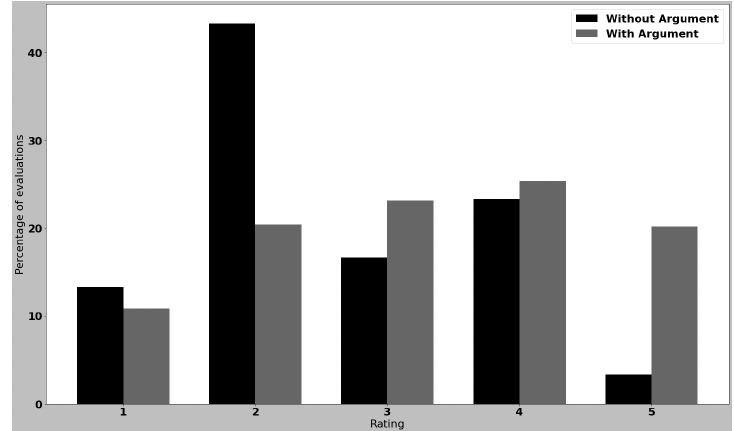
Figure 4. Histogram with the rating comparison between students without and with arguments.